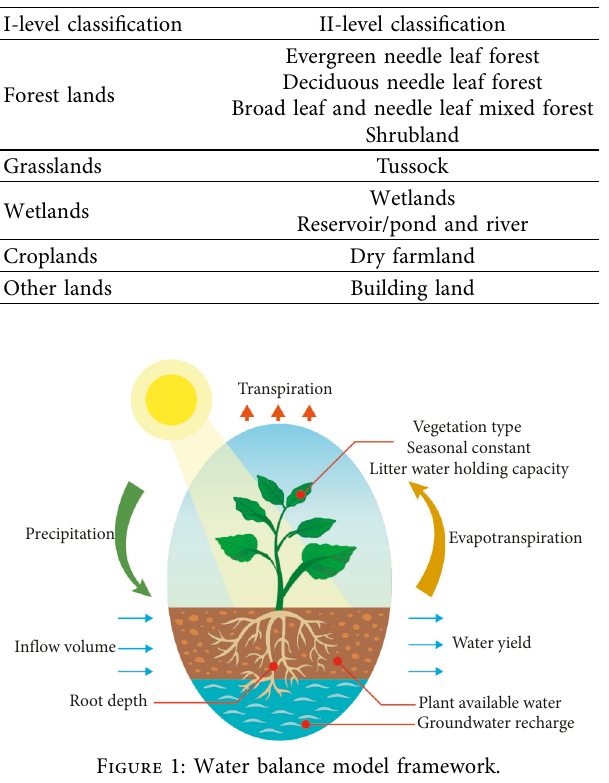
Table 1: Classification system of land cover in the study area.